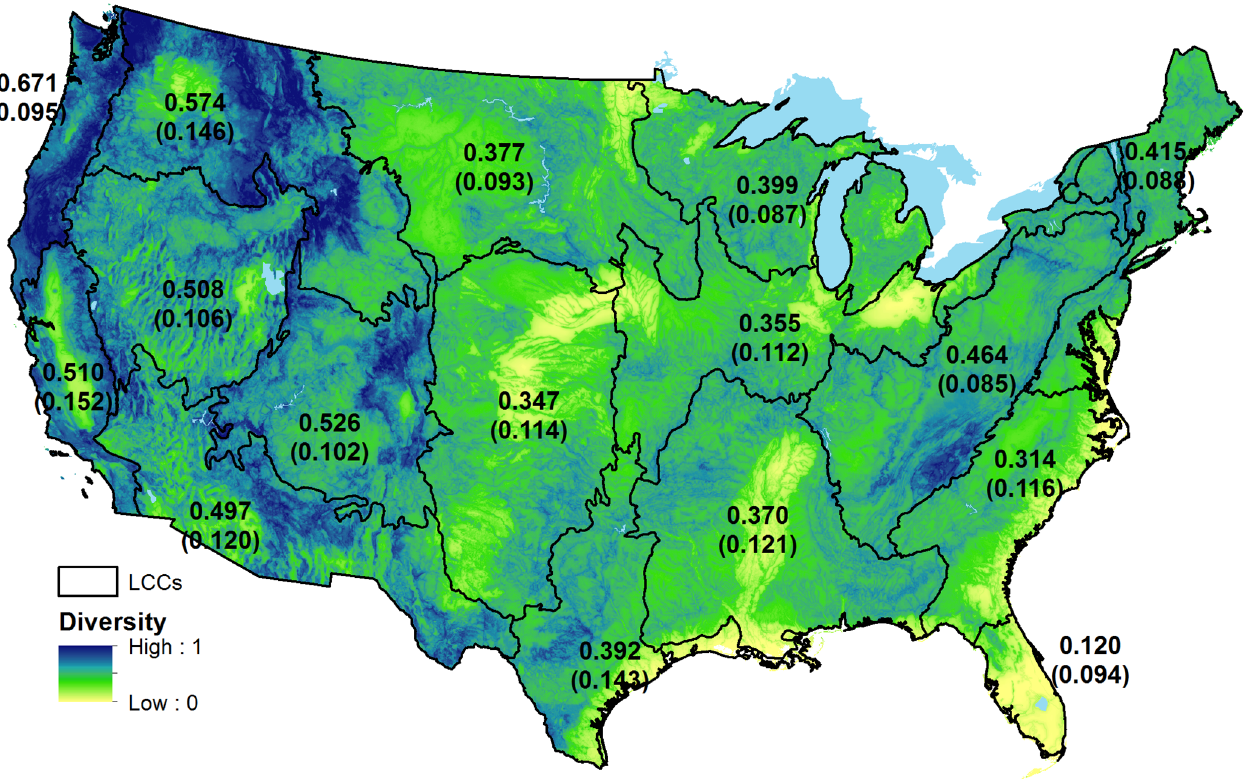
Fig 2. Physiographic diversity in the conterminous USA. Multi-scale physiographic diversity, calculated using the Shannon-Weaver index. Labels are mean diversity by Landscape Conservation Cooperatives, with standard deviations in